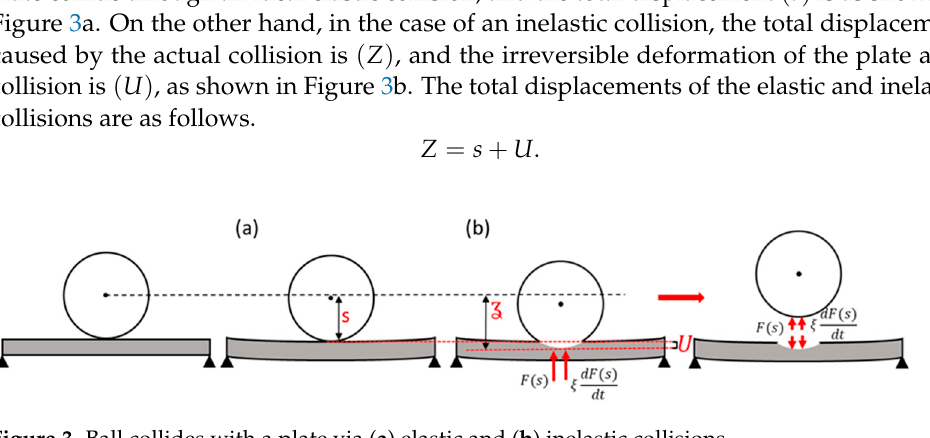
Figure 3. Ball collides with a plate via ( a ) elastic and ( b ) inelastic collisions.